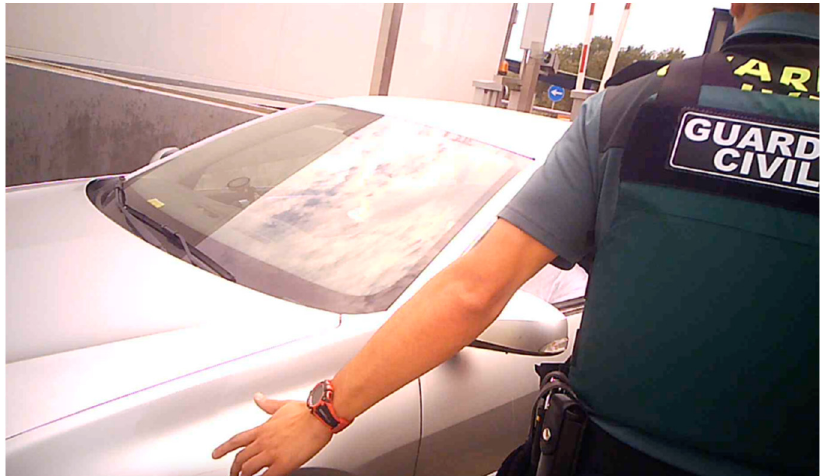
Figure 1. A police officer signals a driver to stop the vehicle by holding up a hand (authors’ data collection).